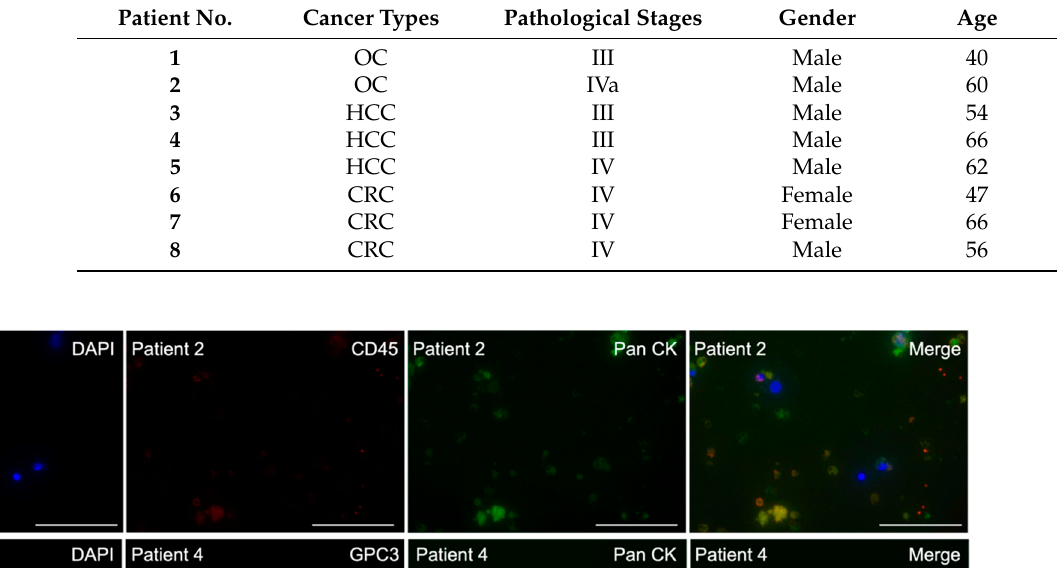
Table 1. Characteristics of cancer patient-derived CTCs.